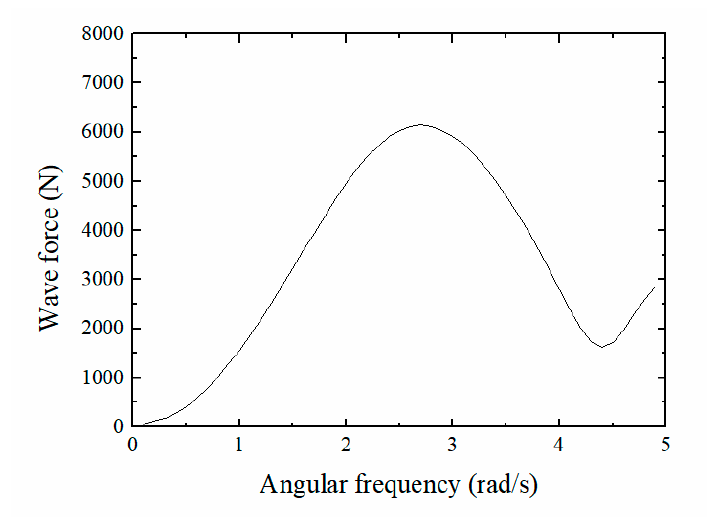
Figure 9. Wave excitation on the float in the pitching direction.